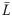
A conceptual representation of measurement combination methods under the log-normal noise model for three SHAPE replicates.Replicates are first transformed into the log domain. The log-average (L¯) and KF (K) profiles are then computed. The resulting profiles are transformed back to the data domain.